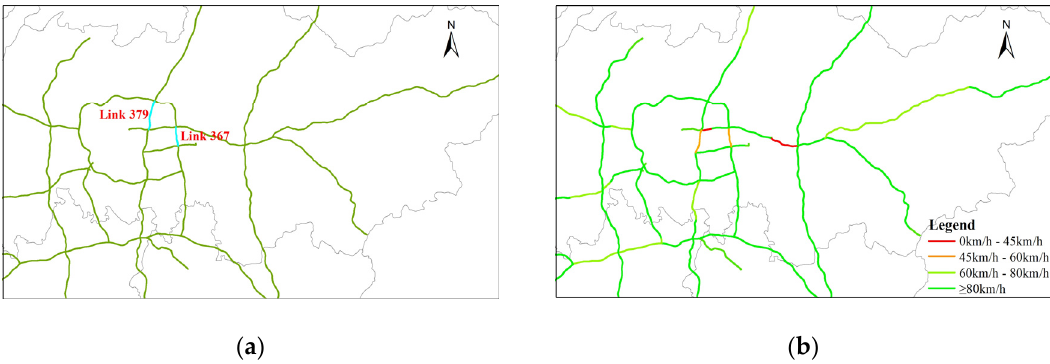
Figure 10. Comparison of links 379 and 367 from a visual perspective. ( a ) Locations of links 379 and 367. ( b ) Traffic